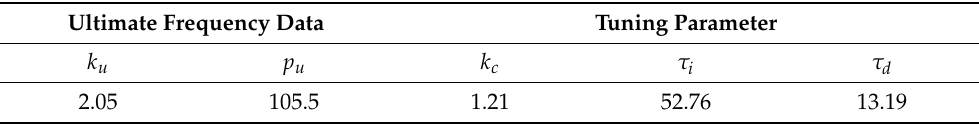
Table 9. Ultimate frequency response data and tuning parameters of the PID controller tuned by the proposed autotuning